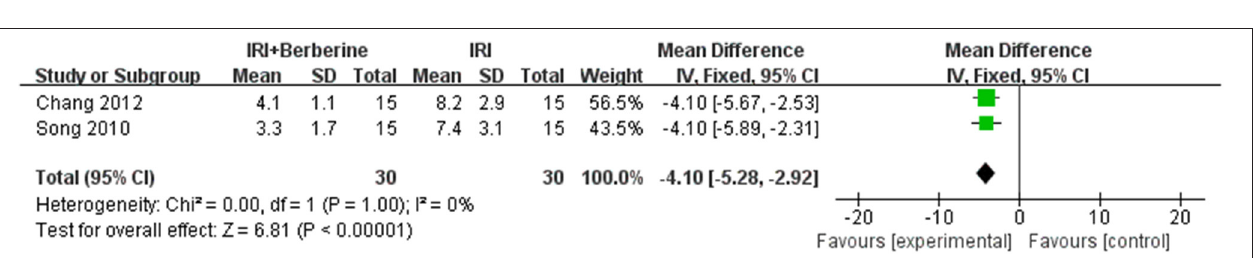
FIGURE 7 | Forest plot showing the effects of BBR on decreasing pre-mature ventricular contraction compared to the control group.